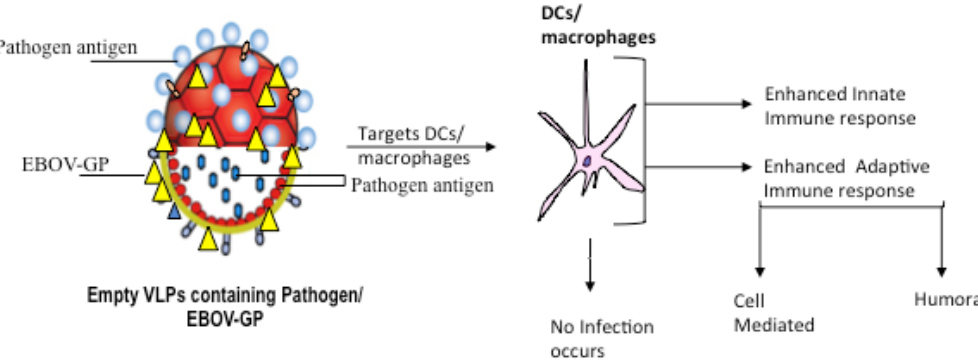
Figure 2. Schematic diagram of the incorporation or infusing pathogen antigen on EBOV GP to target DCs for the induction of immune responses. Using the technology of EBOV GP VLP immunological basis, it is possible to incorporate EBOV VLPs with other viral antigens to induce an efficient humoral and adaptive cellular immune responses.